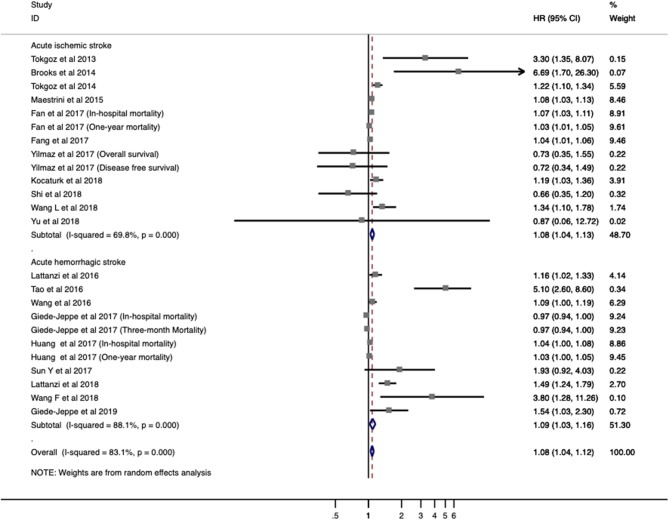
Meta-analysis of the association between NLR and mortality in patients. Results are presented as individual and pooled risk ratios (RRs) with 95% confidence intervals (CIs).